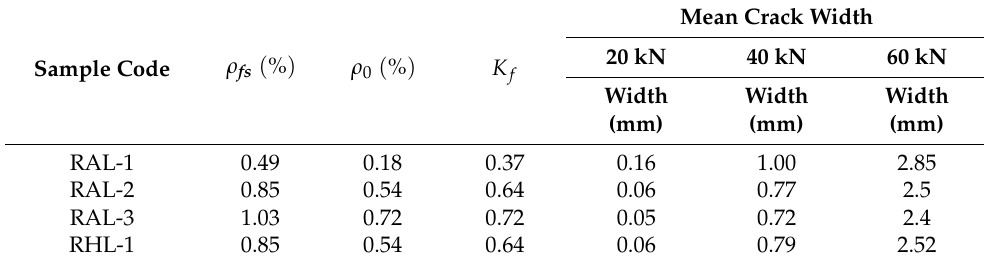
Table 6. The measured values of crack width of test